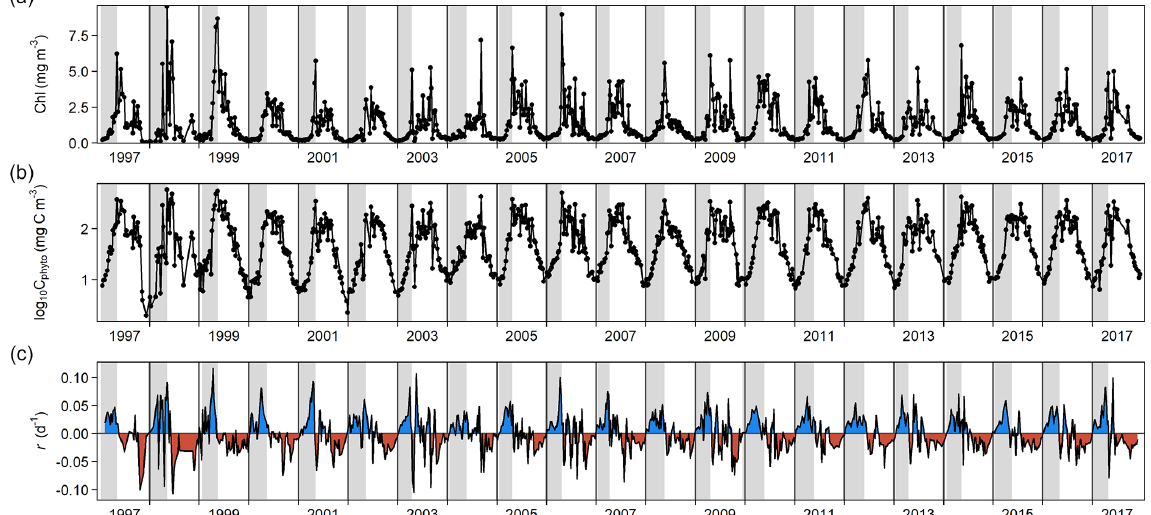
Figure 1. Changes through time in (a) chlorophyll a (Chl) concentration, (b) log-transformed phytoplankton biomass ( C phyto ) concentration, and (c) biomass accumulation rate ( r ). Blue and red areas in (c) indicate positive and negative r , respectively. Vertical gray stripes correspond to the estimated spring bloom span each year, from t 0 to t maxC (see Methods). For 1997, we used the average date of the spring bloom onset estimated using the rest of the time series (6